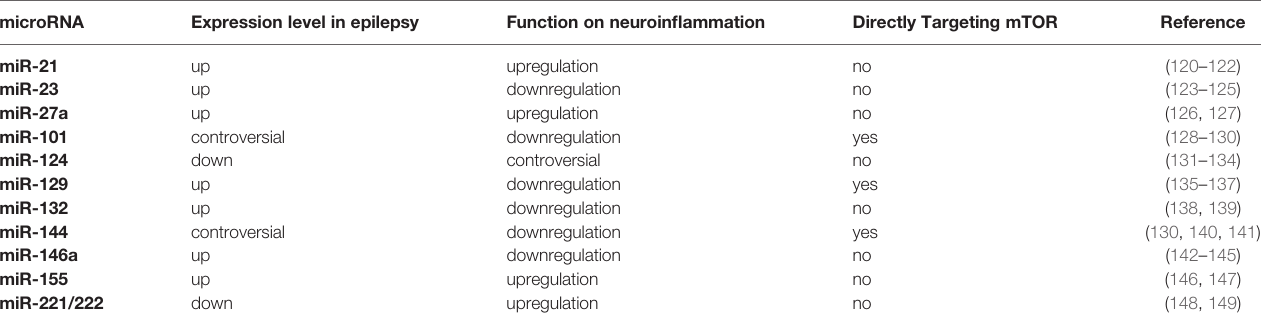
TABLE 1 | Summary of mTOR-related miRNAs in epileptic neuroin fl